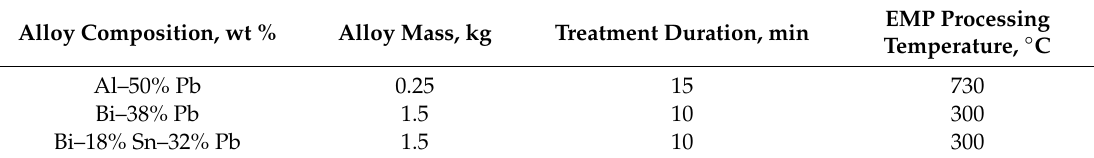
Table 1. Experimental